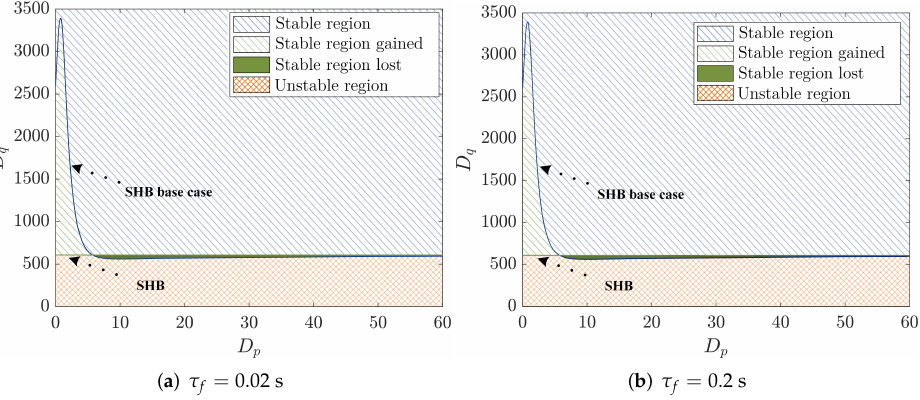
Figure 10. Region of stability of the plane D q – D p before different values of τ f .